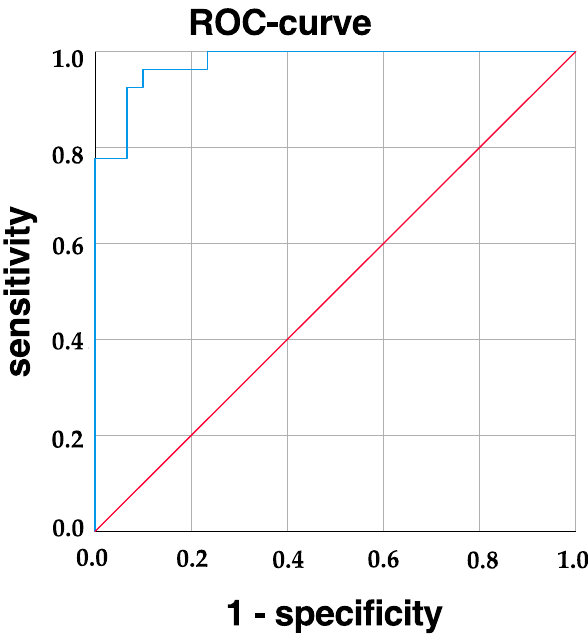
Figure 4. ROC curve showing sensitivity for correct diagnosis of FAS.